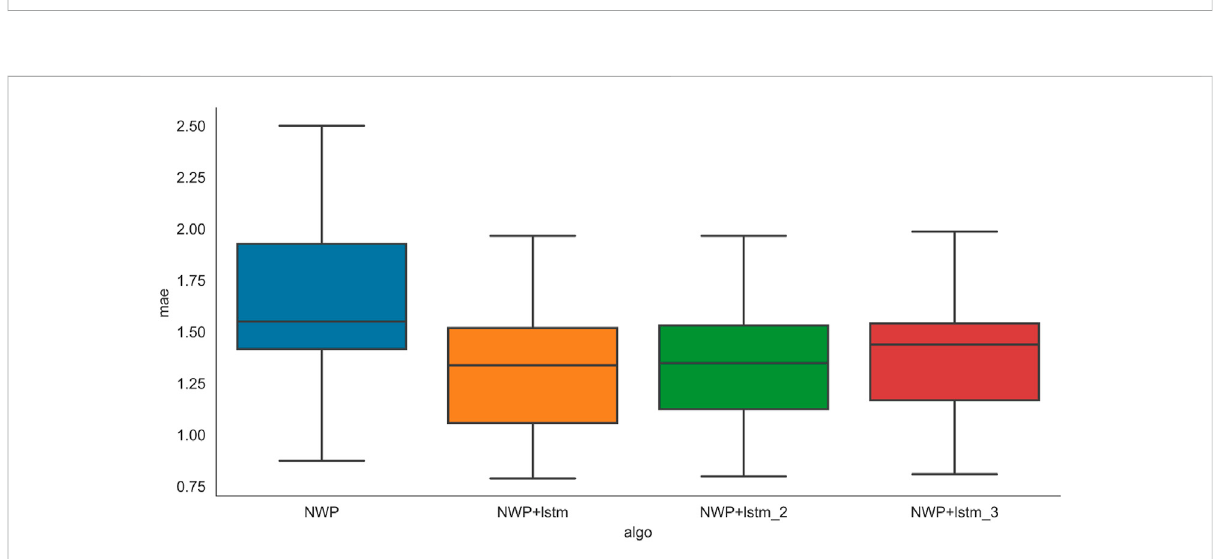
FIGURE 15 Overall mae results for different prediction steps based on the